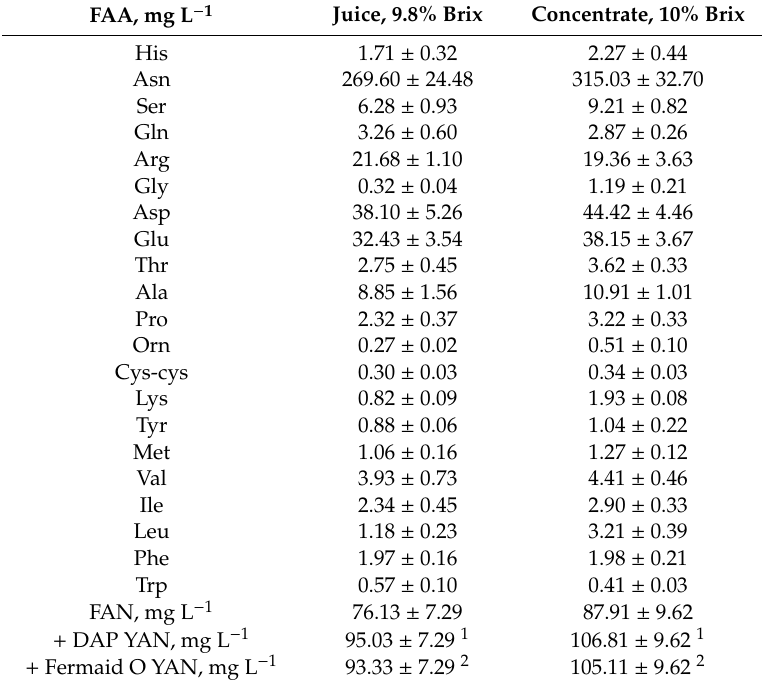
Table 1. Free amino acid (FAA) composition, free amino nitrogen (FAN) content before and yeast assimilable nitrogen (YAN) content after supplementation. Standard deviation is shown ( n = 3).